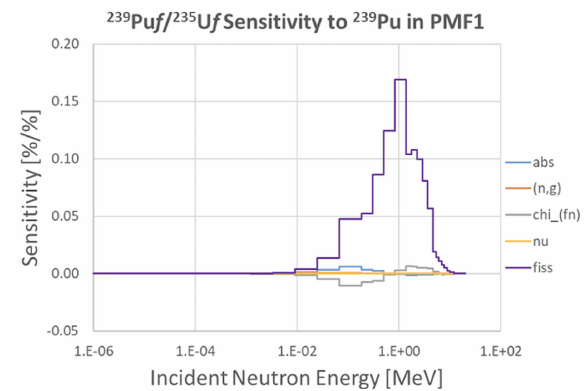
Figure 8. Sensitivities of the 239 Pu(n,f) / 235 U(n,f) reaction rate in the Jezebel critical assembly to selected 239 Pu nuclear data are shown.